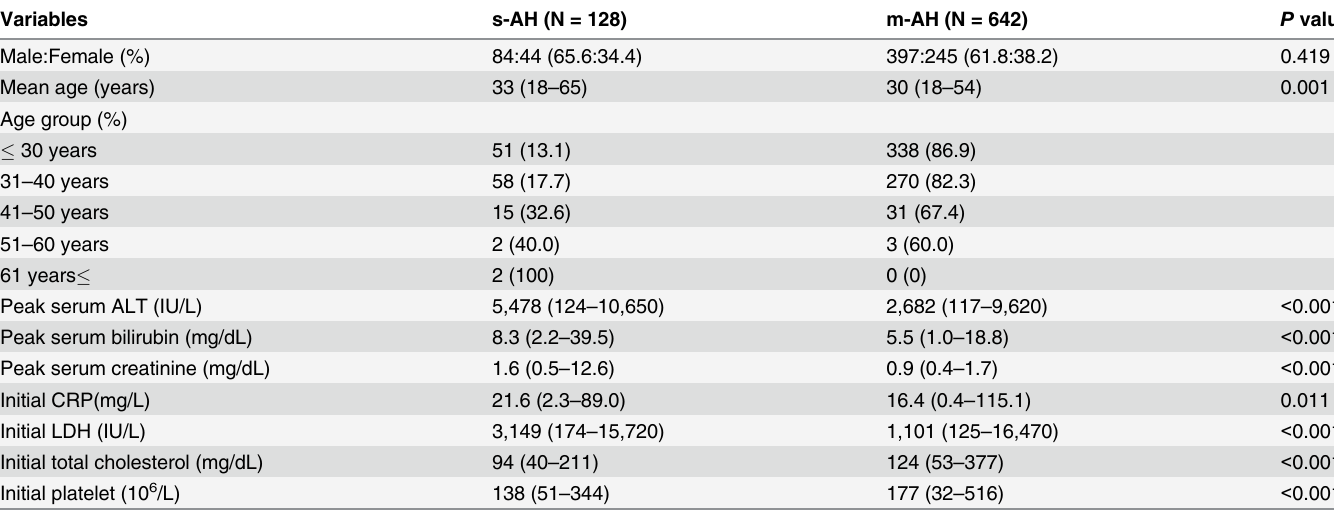
Table 1. Clinical characteristics of 770 patients with acute hepatitis